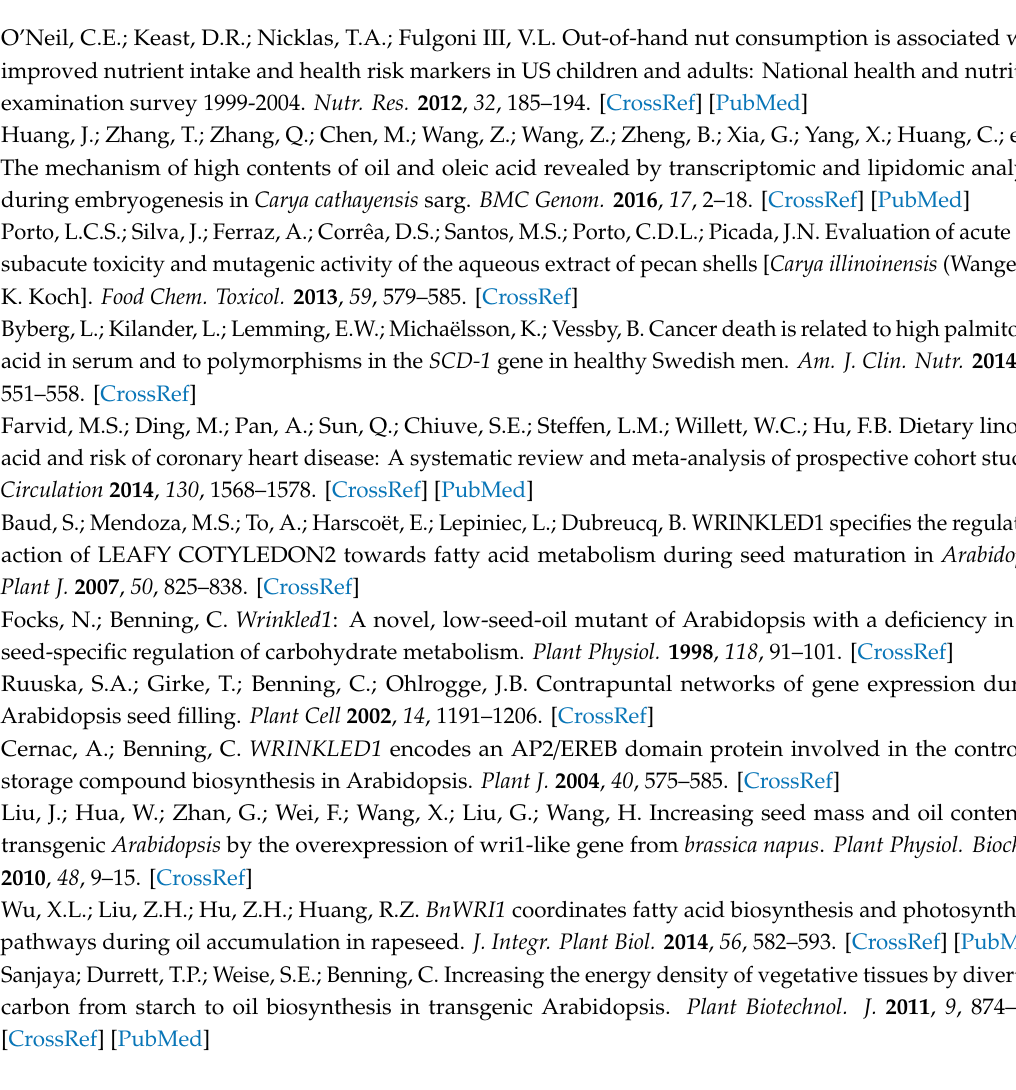
(ORF) and deduced amino acid sequence of CiWRI1. Figure S3 Subcellular localization of CiWRI1. Figure S4 Open reading frame (ORF) and deduced amino acid sequence of CiBCCP2. Figure S5 Subcellular localization of CiBCCP2. Table S1: Primer sequences used this